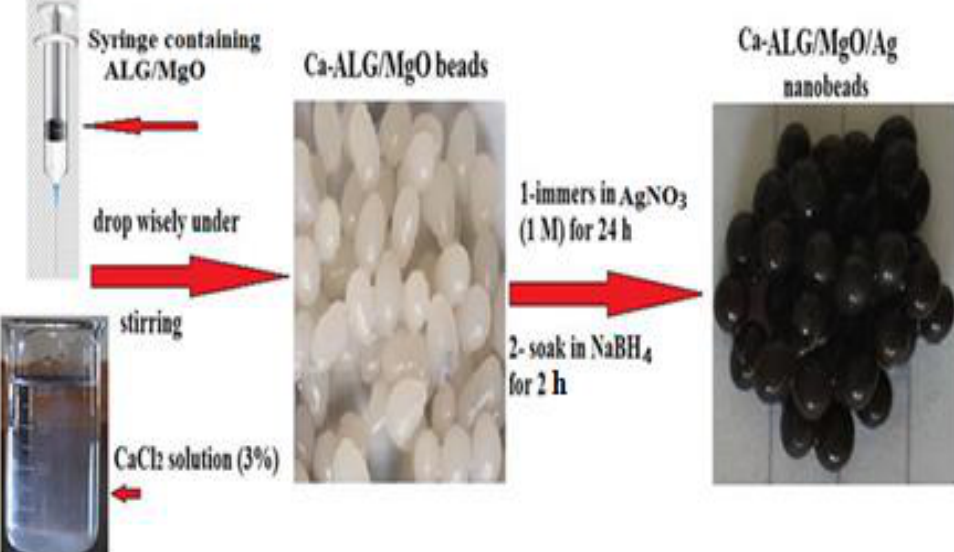
Figure 12. Steps of preparation of Ca-ALG/MgO/Ag nanocomposite beads supported with digital photos.